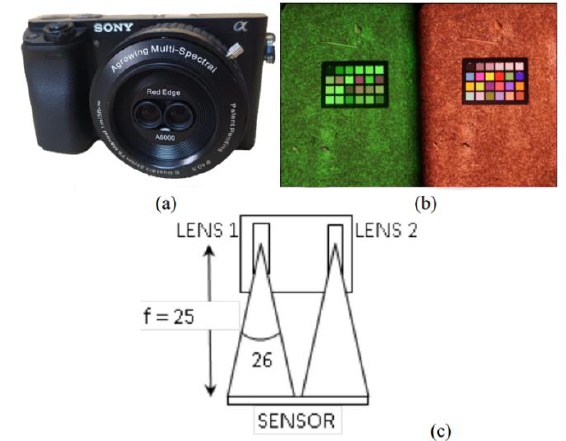
Figure 1 . (a) Multispectral camera with two heads; (b) original frame collected with an Agrowing dual-head; (c) and the diagram for the dual-head camera (adapted from Tommaselli et al., 2019).